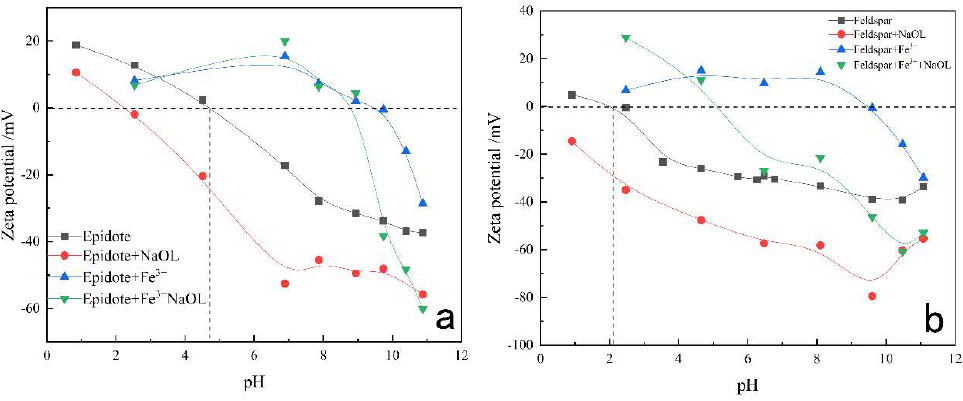
Figure 6. Zeta potential of epidote ( a ) and feldspar ( b ) with and without Fe 3+ as a function of pH.